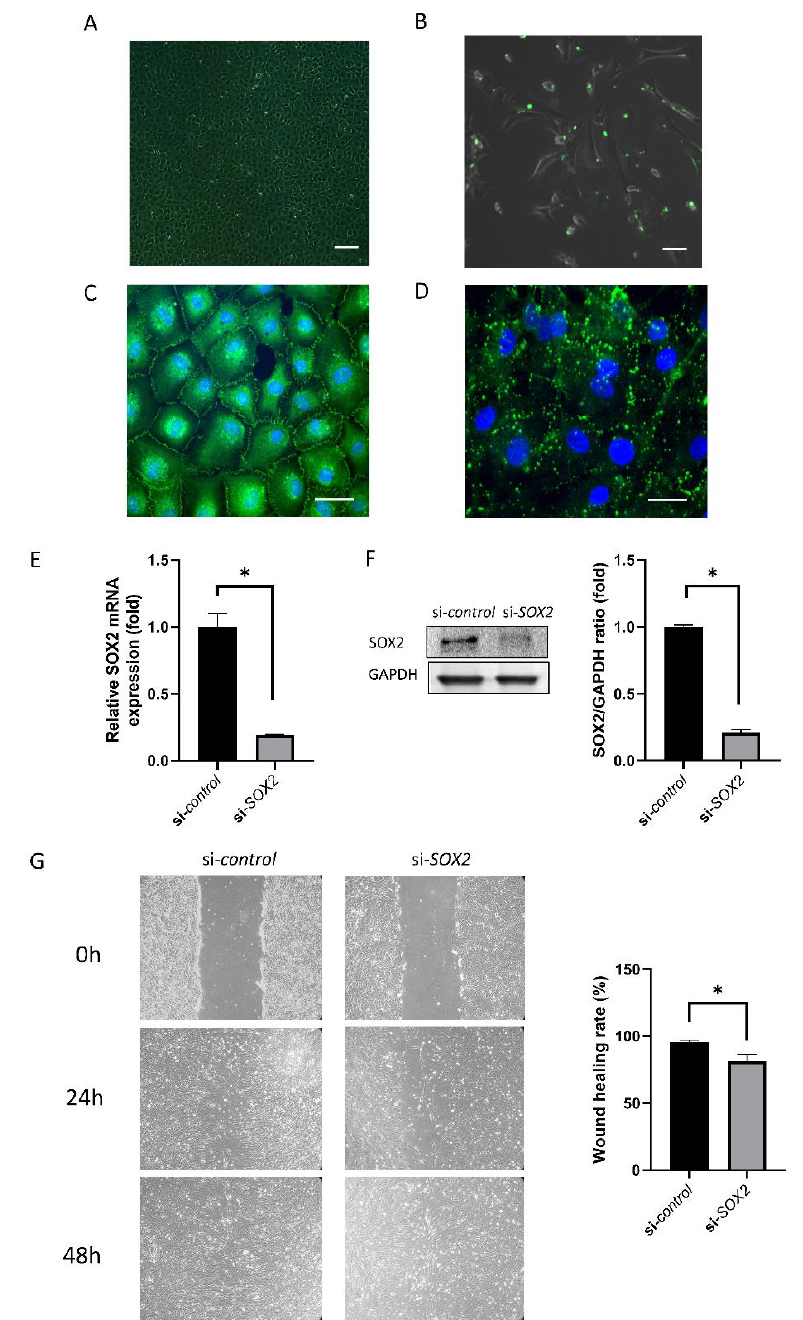
Figure 1. Human corneal endothelial cell (hCEC) culture and transfection of siRNA. ( A ) hCECs cultured at P0. The scale bar denotes 200 μm. ( B ) Green fluorescence of transfected cells indicates fluorescein isothiocyanate-conjugated control siRNA at 48 h after transfection. The confluency of the cells at the time of transfection should be about 70%. The scale bar denotes 100 μm. ( C ) Immunostaining for zonula occludens-1 (ZO-1). Green is ZO-1 and blue is Hoechst 33,342 nuclear staining. The scale bar denotes 50 μm. ( D ) Immunostaining for zonula connexin 43 (Cx43). Green is Cx43 and blue is Hoechst 33,342 nuclear staining. The scale bar denotes 50 μm. ( E , F ) sex-determining region Y-box 2 (SOX2) level was evaluated using RT-PCR and Western blotting. ( G ) Scratch assay monitoring the wound healing rate. Wound healing was delayed in si -SOX2 -transfected cells. * indicates statistical significance by independent t -test.